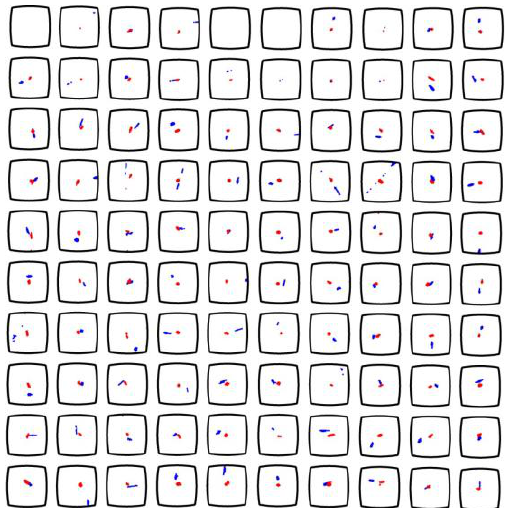
Figure 4. Detailed experimental evaluation of the trapping and positioning performance of 10 µm particles in the ring-transducer device. Scale bar is indicated by the wells (350 µm wide squares with slightly rounded walls). The actuation frequency is 2.30 MHz (single-frequency, blue aggregates) and 2.30 ± 50 kHz at the modulation rate 1 kHz (frequency-modulation, red aggregates). The figure is based on results presented in Ref.